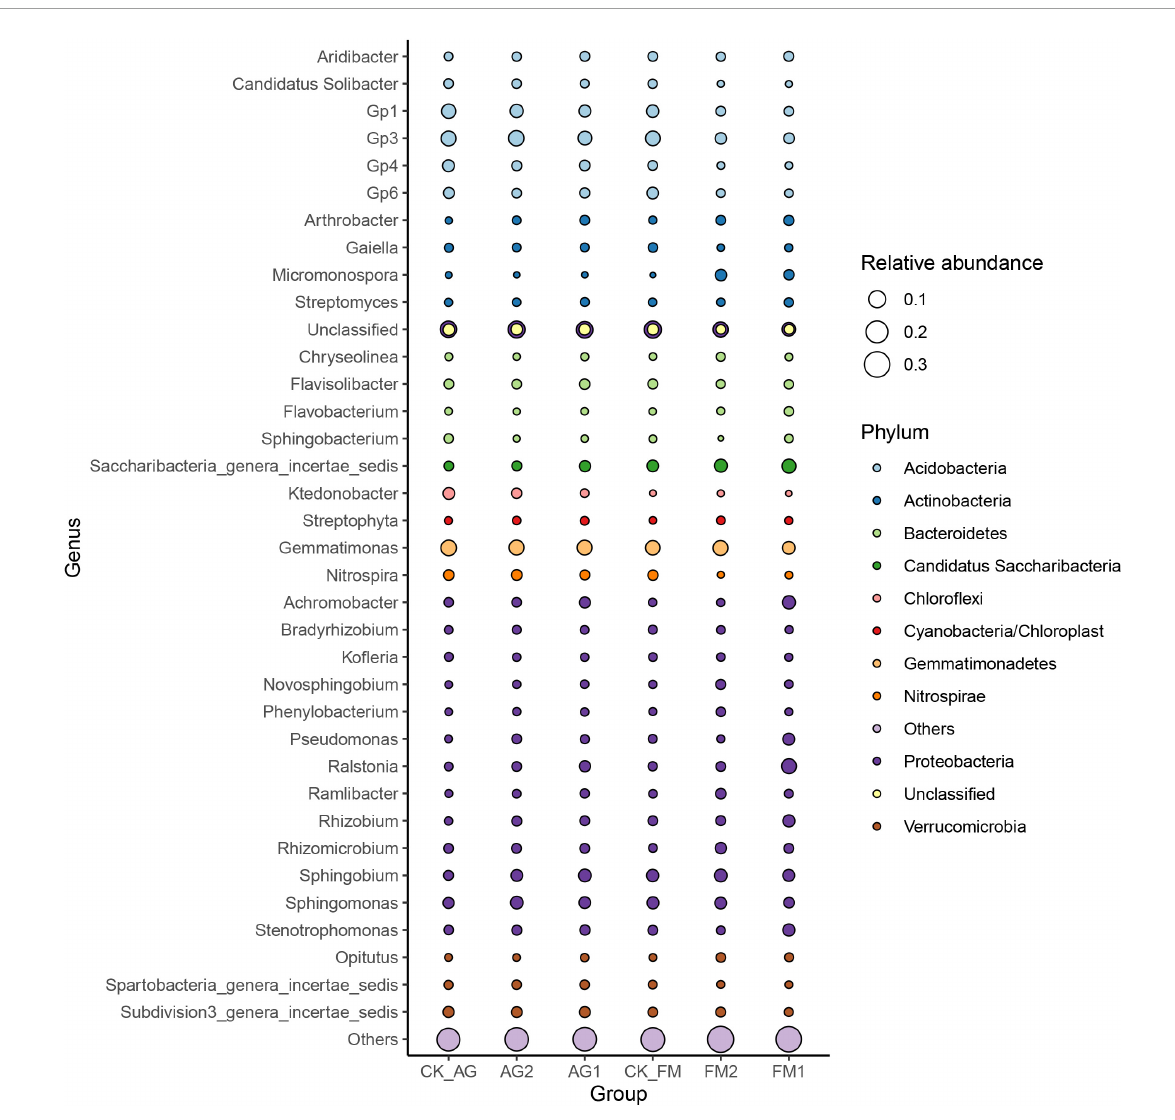
FIGURE4 Bacterial community structure at genus and phylum level as indicated by bubble plot. Bubble size represents the abundance (0–1) of each genus, and the color of the burble indicates the phylum. AG1, microbial agent 1 treatment; AG2, microbial agent 2 treatment; CK_AG, untreated control in biological treatment experiment. FM1, CoCl 2 , cobalt dichloride fumigation treatment; FM2, dazomet fumigation treatment; CK_FM, untreated control in fumigation